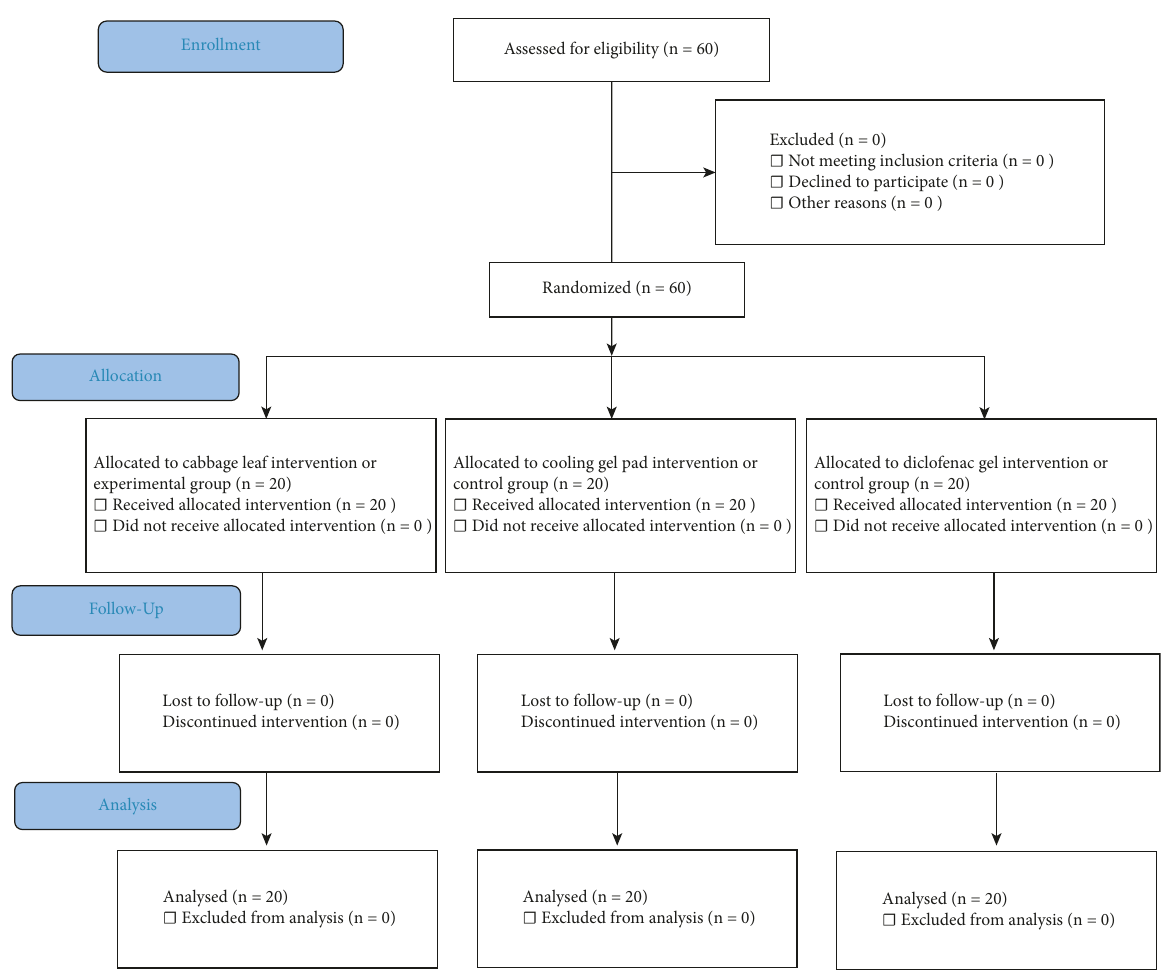
Figure 2: CONSORT flow